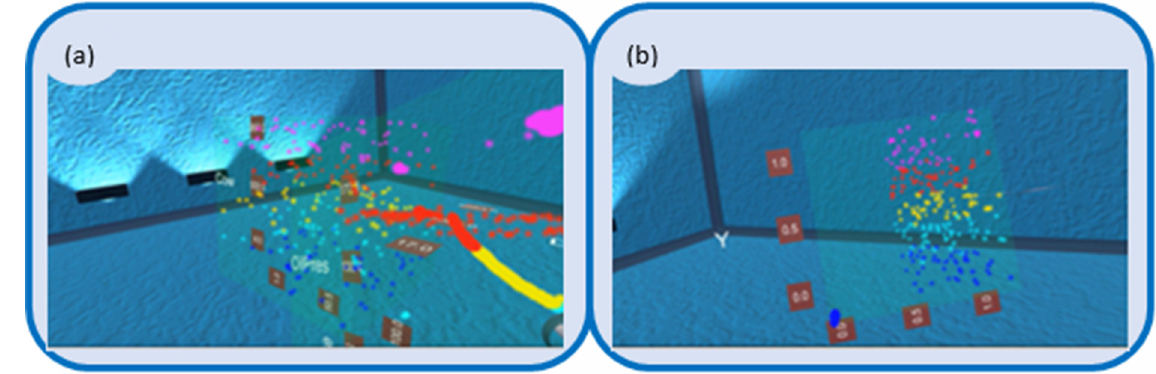
Figure 11. The merge element system ( a ) A side view. ( b ) A front view of the graph.